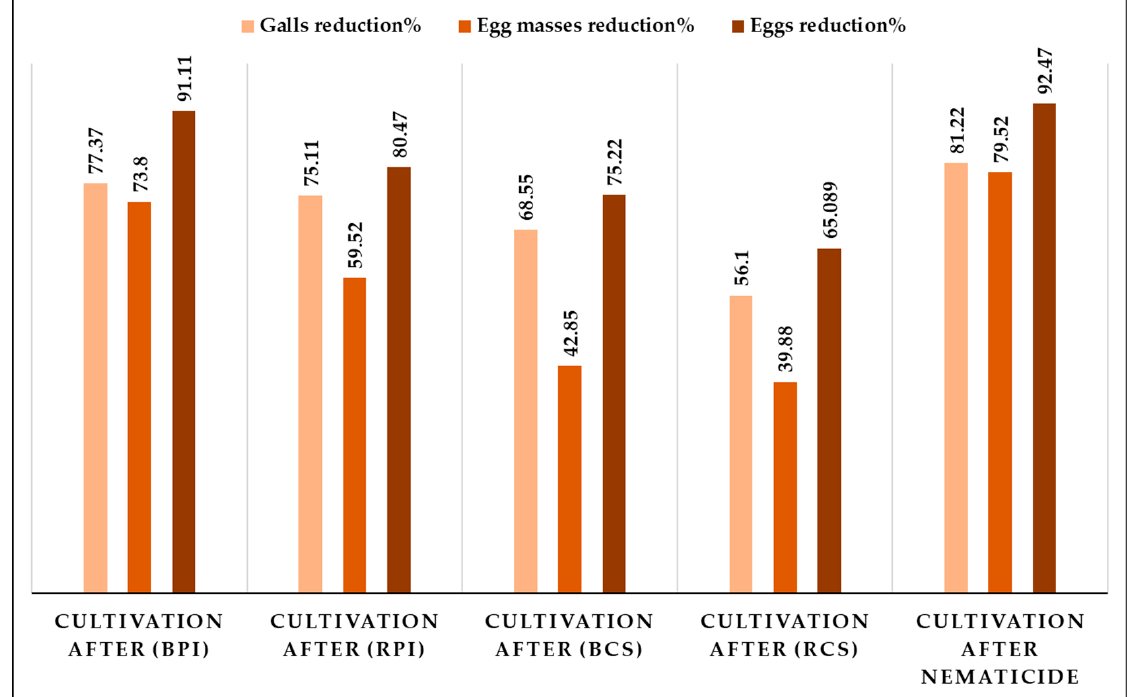
Figure 7. The effects of biofumigant, crop sequence, and nematicide treatments on gall, egg ‐ mass, and egg numbers reduction in cucumber roots. Level of reduction of treatments was estimated according to reduction of nematode parameters compared with mean of control plants.